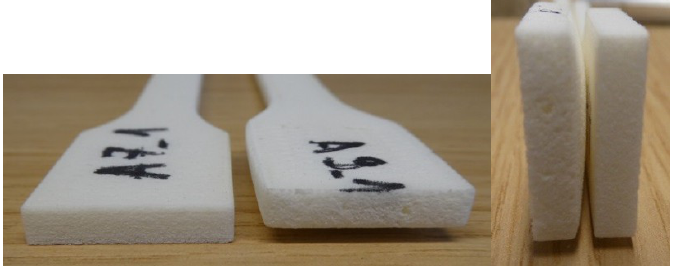
Figure 13. Geometrical deformation with higher energy input—comparison of one test specimen in series A7 and A9.